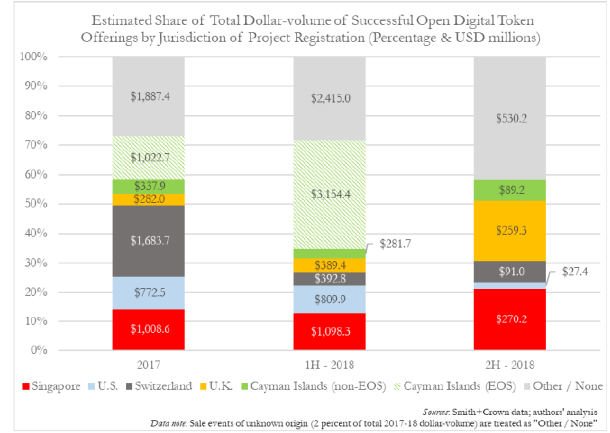
Figure 1. Unlike other jurisdictions, Singapore was a leading home of open digital token offerings during both 2017